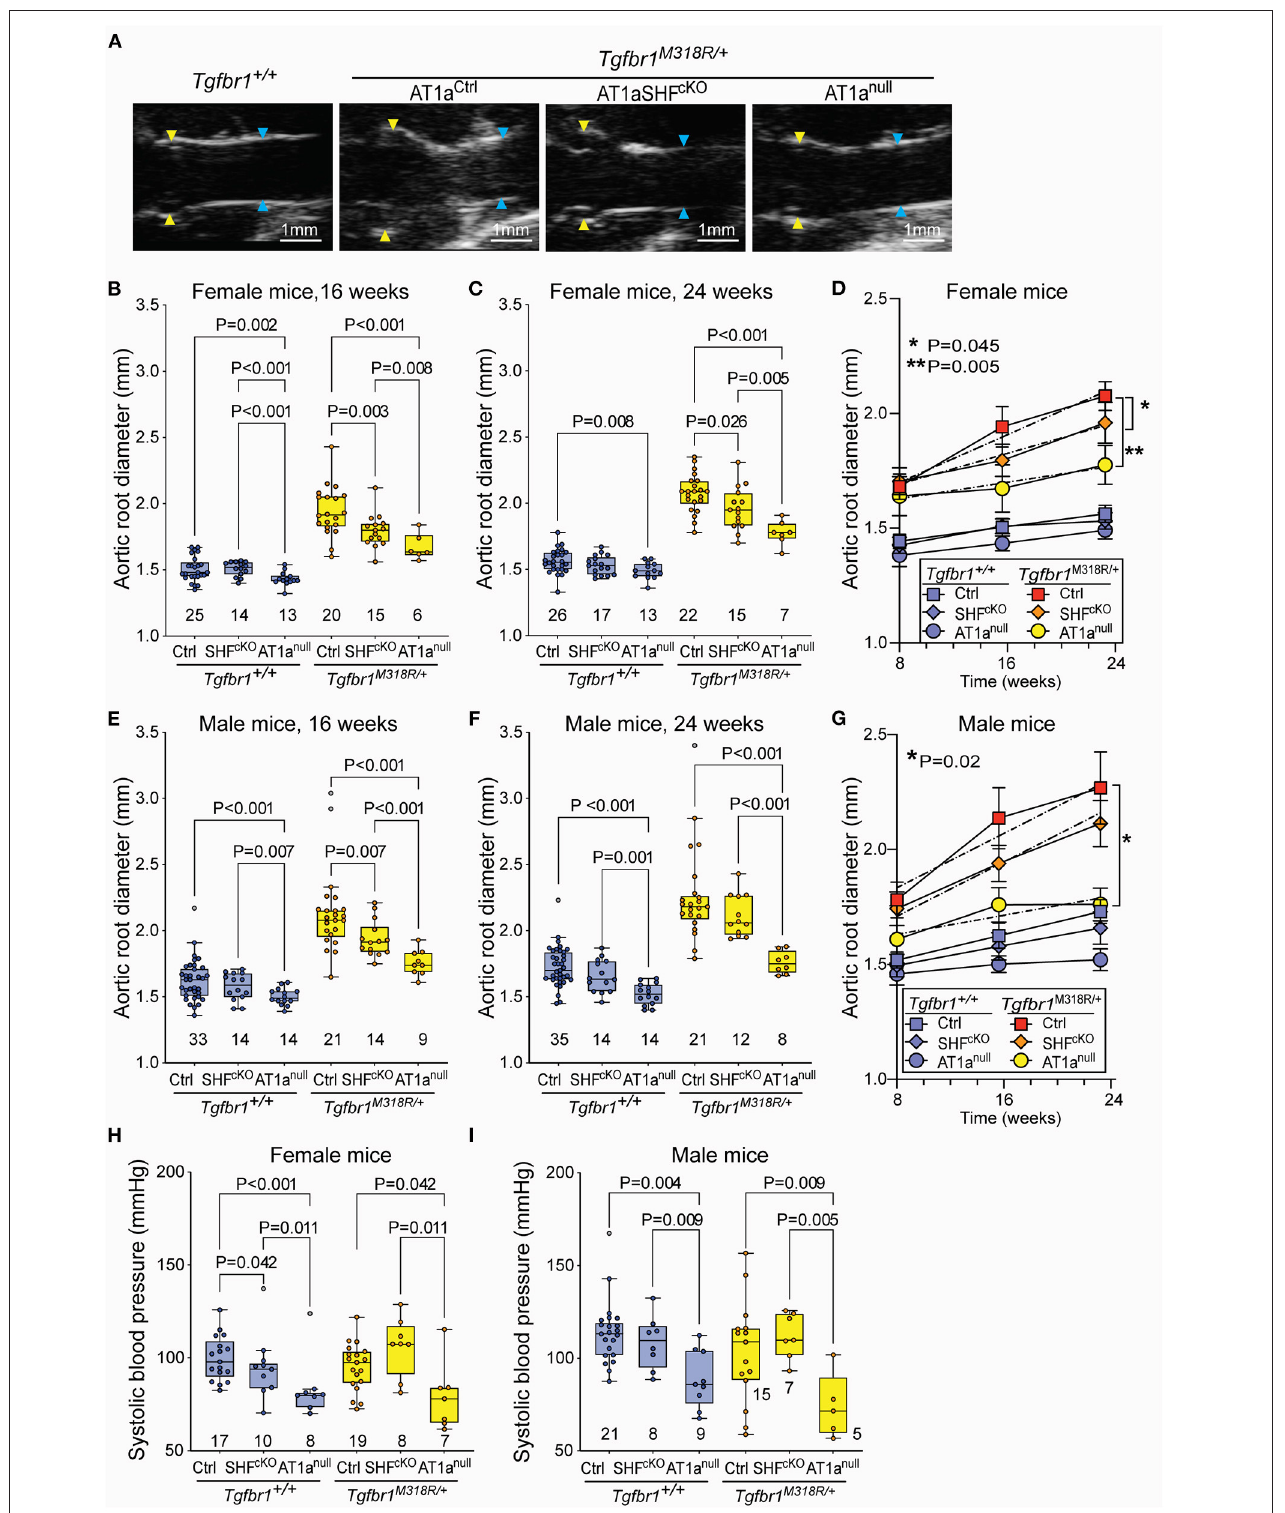
FIGURE 1 | Global and SHF-specific deletion of Agtr1a result in reduction of aortic root dilation in LDS mice. (A) Representative echocardiograms of Tgfbr1 + / + and Tgfbr1 M318R / + mice with and without conditional (AT1a SHFcKO ) or global (AT1a null ) deletion of Agtr1a , the aortic root is indicated by yellow arrows while the ascending aorta is indicated by blue arrows. Aortic root diameter as measured by echocardiography in both females (B–D) and males (E–G) at indicated time points. Tgfbr1 + / +